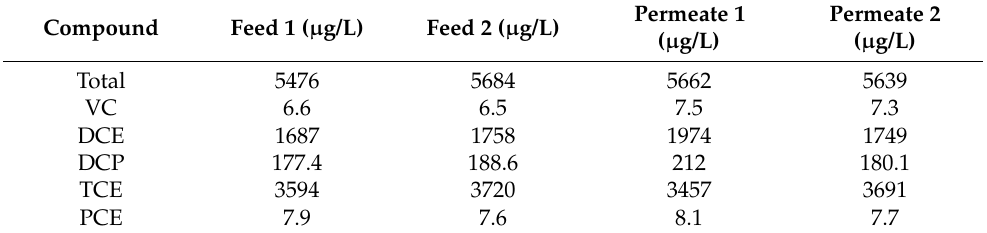
Table 6. GC–MS data of five main components detected for the 27th May samples.